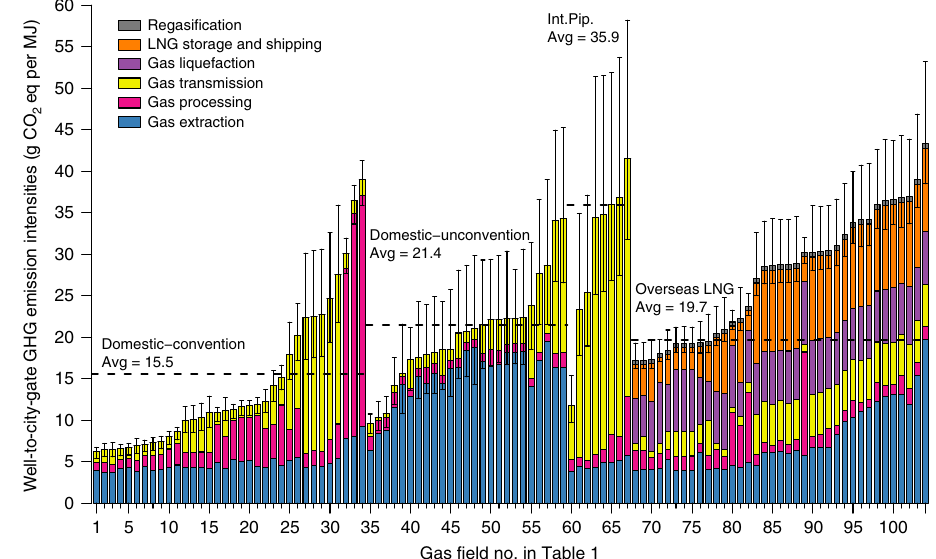
Fig. 1 Well-to-city-gate GHG intensities of natural gas supplies from individual fi elds to China using 100-year timeframe global warming potential (GWP 100 ). Different colors show the breakdown of emissions by individual processes. Error bars represent the 90% con fi dence intervals (CI) of the estimates with Monte Carlo simulation of uncertain parameter inputs (see Supplementary Discussion 1 and 2 for details). Source data are provided in a Source Data fi le.